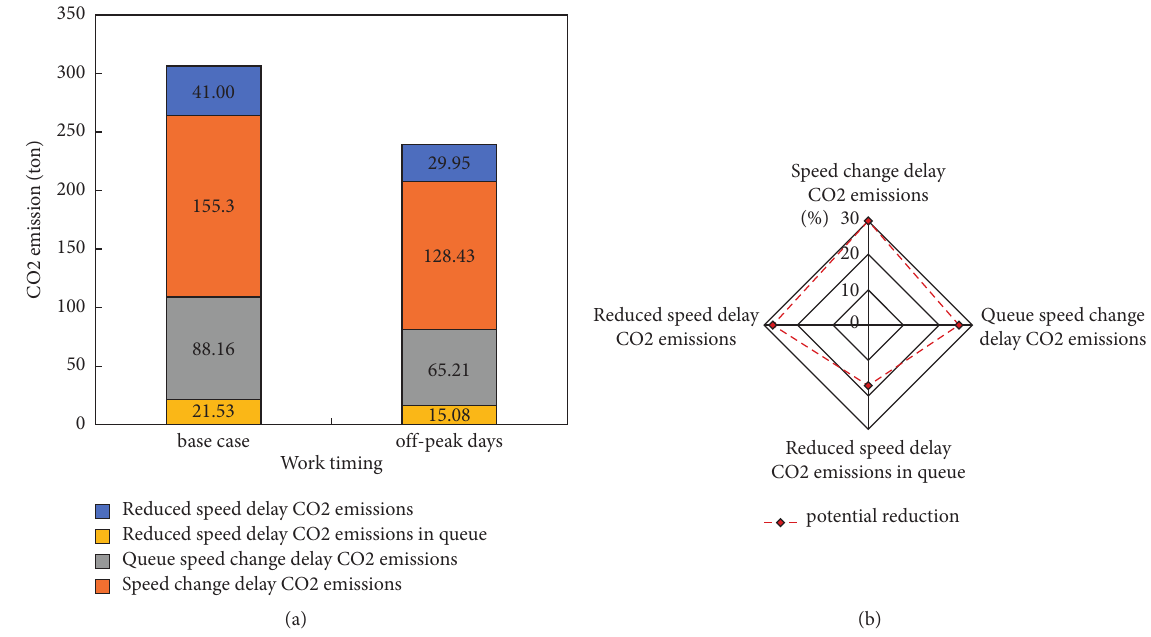
Figure 7: (a) Total work zone user CO 2 emissions before and after work zone timing change; (b) potential reduction regarding different work zone user CO 2 emissions component under work zone timing change.